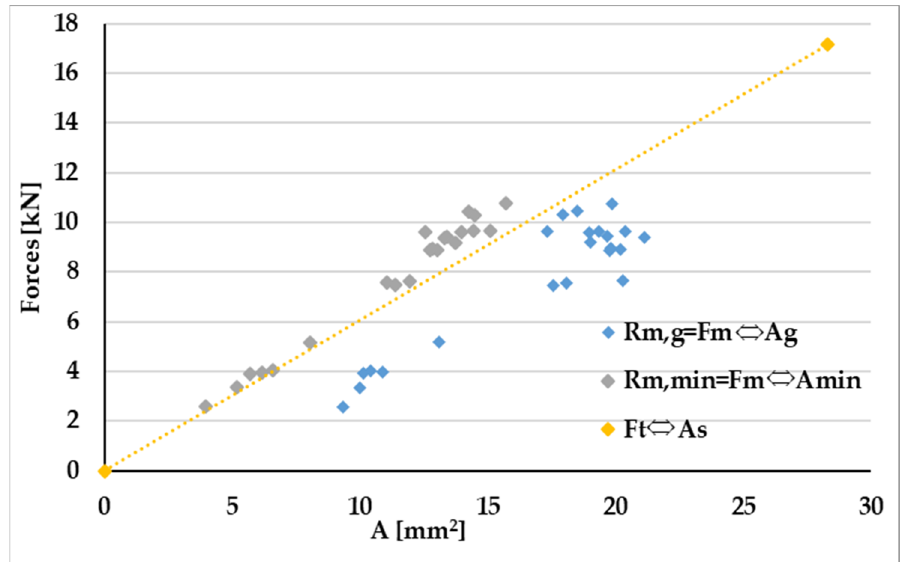
Figure 6. Dependence of the force F m on the tensile strength R m related to the relevant area of the cross-section ϕ 6 (to minimum area A min and to the area determined from the weight loss A g ).